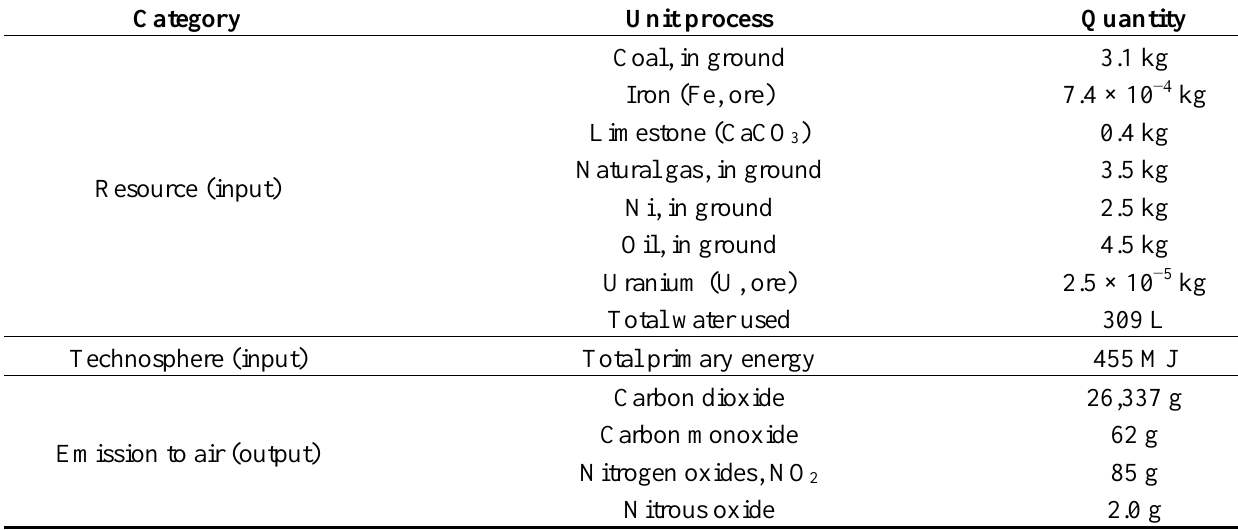
Table 1. Inventory data for nickel oxide (NiO) production (1 kg of nickel (Ni) in NiO) [30]. Reprinted/Reproduced with permission from Nickel Institute,